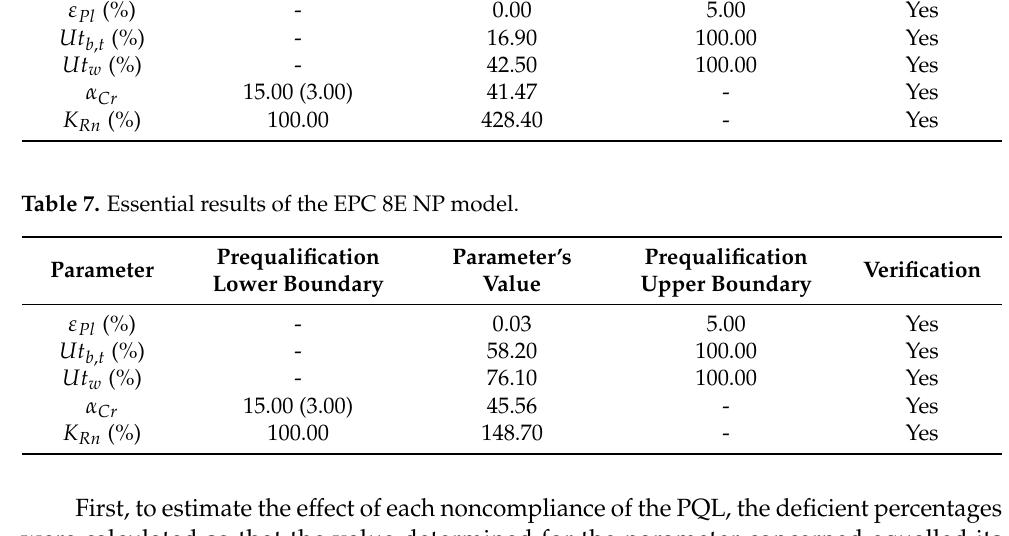
Table 8. Beam parameter dimensional savings percentages.